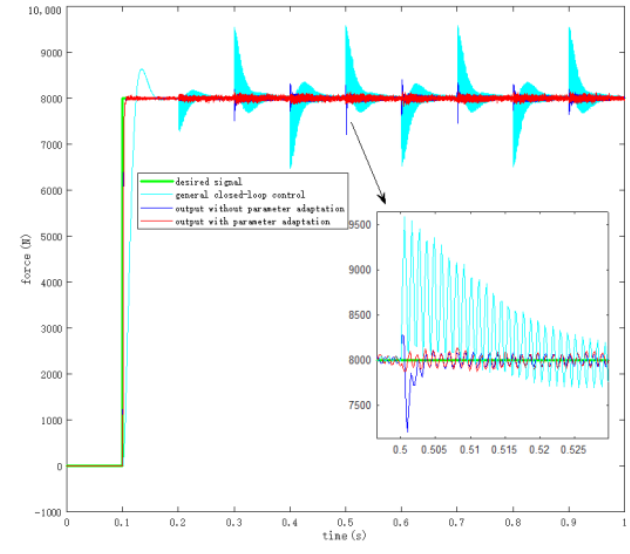
Figure 14. System output under different control methods.